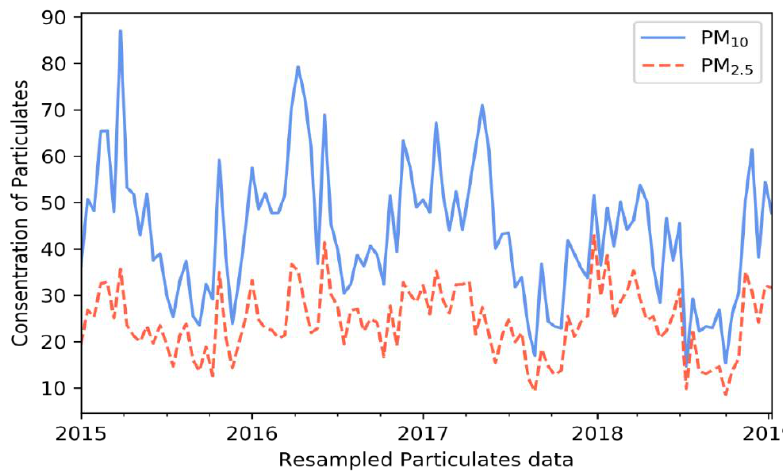
Figure 2. Concentration trends of the resampled particulate matter (PM) data.